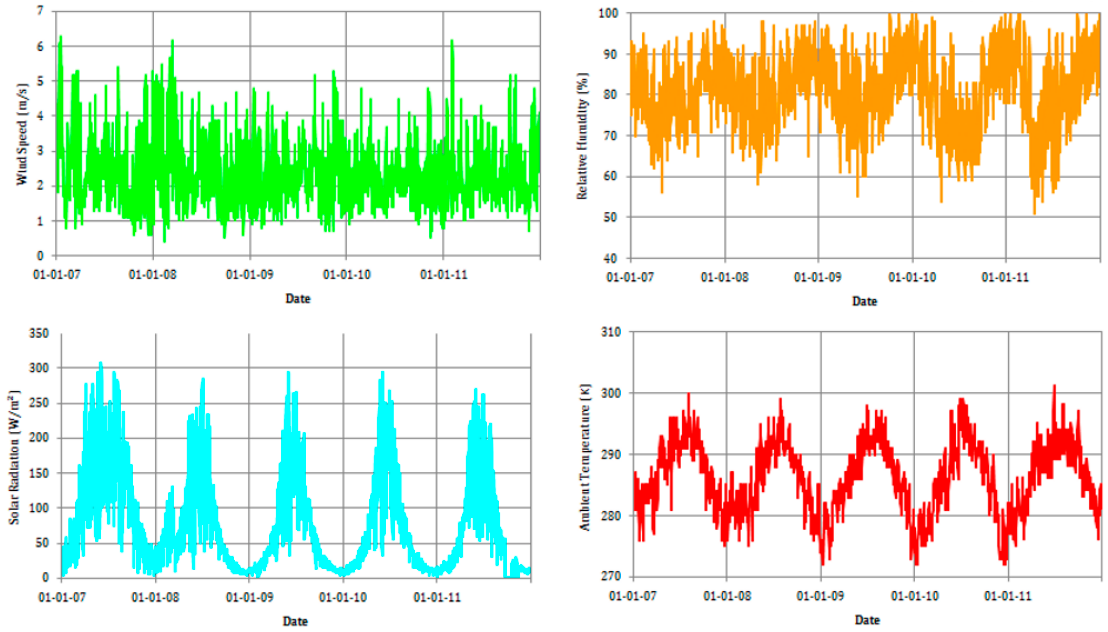
Figure 7. Variation in daily mean values of weather parameters [26]. Table 4. Statistics of weather parameters dataset.